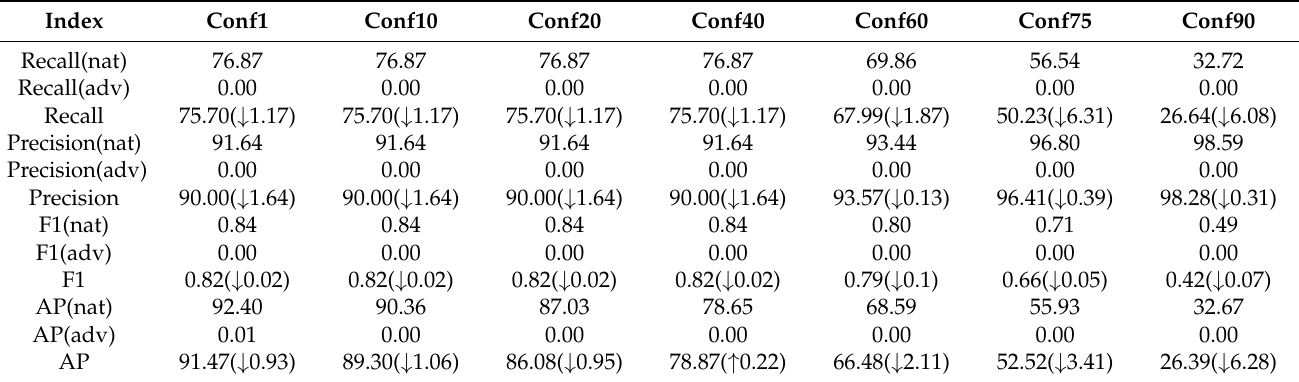
Table 1. The detection performance of the YOLOv3 without our defense algorithm on clean images and the adversarial patch attack, and the detection performance of the YOLOv3 with our defense algorithm under the adversarial patch attack.